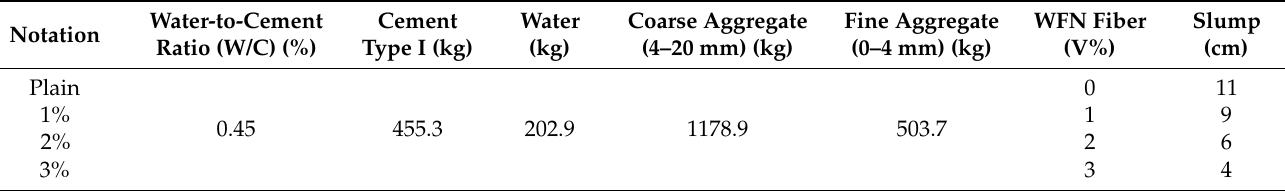
Table 3. Mixture design for 1 m 3 volume of concrete mix.